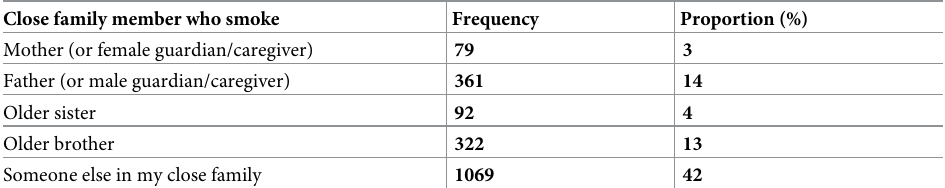
Table 3. Respondents report on family members who smoke.